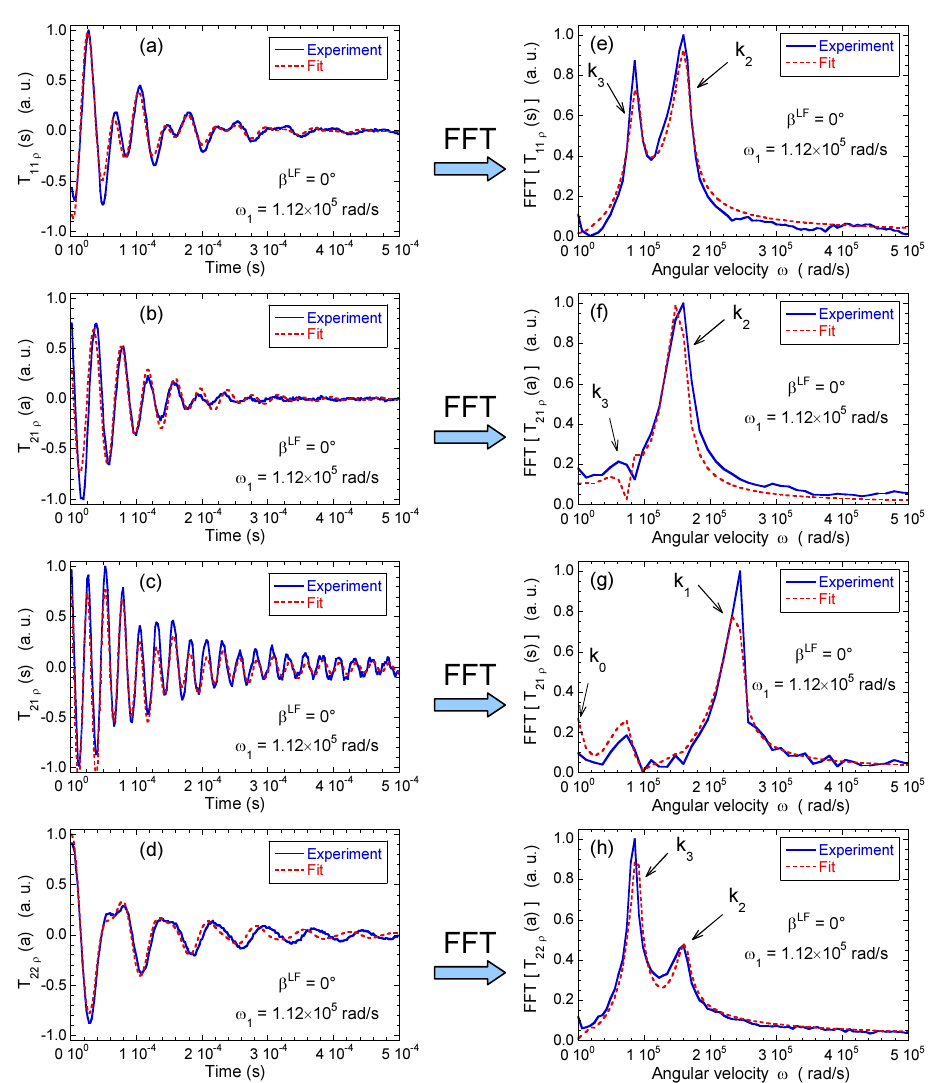
Figure 8. Time evolution of ( a ) T 11 ( s ) ; ( b ) T 21 ( a ) ; ( c ) T 21 ( s ) and ( d ) T 22 ( a ) coherences mea- sured under spin-locking conditions, noted T 11 ρ ( s ) , T 21 ρ ( a ) , T 21 ρ ( s ) and T 22 ρ ( a ) , respectively, and their Fourier transforms for ( e ) T 11 ( s ) ; ( f ) T 21 ( a ) ; ( g ) T 21 ( s ) and ( h ) T 22 ( a ) coherences ( 2 H NMR). These Fourier transforms better illustrate the contribution from the characteristic angular veloc- ities k i ; see Equation (6). Reprinted with permission from Ref. [80]. Copyright (2014) American Chemical Beidellite B1 2w article Juin 2014